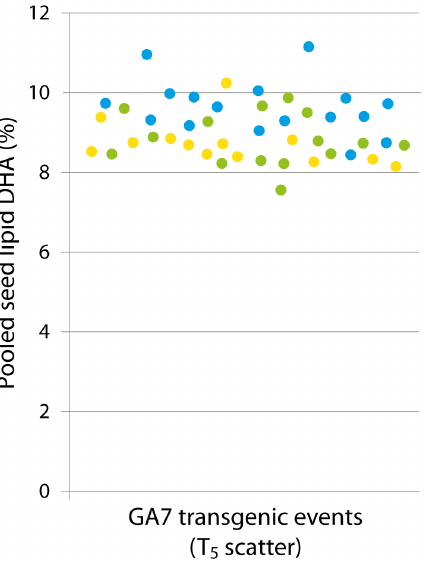
Figure 6. Relative level of DHA (as % of total fatty acids) of pooled seed from 60 randomly-selected plants from the T 5 generation of GA7 transgenic. Events are colour-coded by glasshouse location (yellow, green and blue dots denote different glasshouses). The blue events were found to contain more DHA than the events in the other glasshouses (P , 0.001).